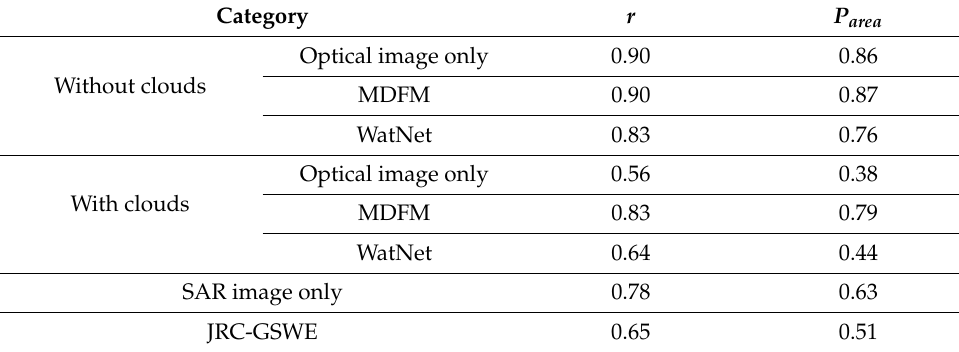
Table 6. Water extraction accuracy table of WatNet and